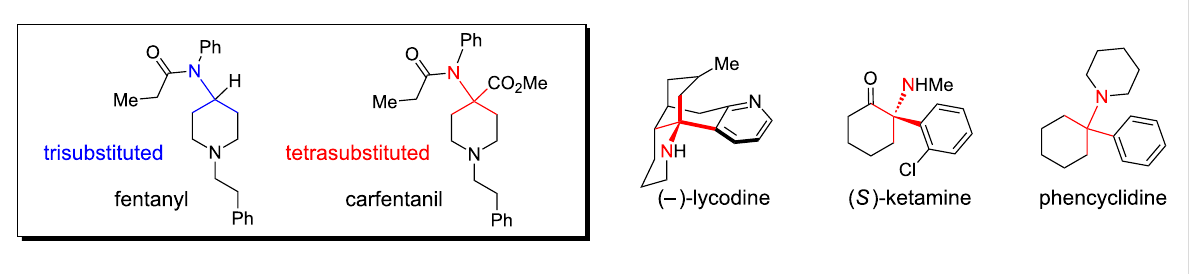
Figure 2: A tetrasubstituted carbon bearing an amine (red) can provide 100-fold increase in activity compared to the trisubstituted carbon bearing an amine (blue).